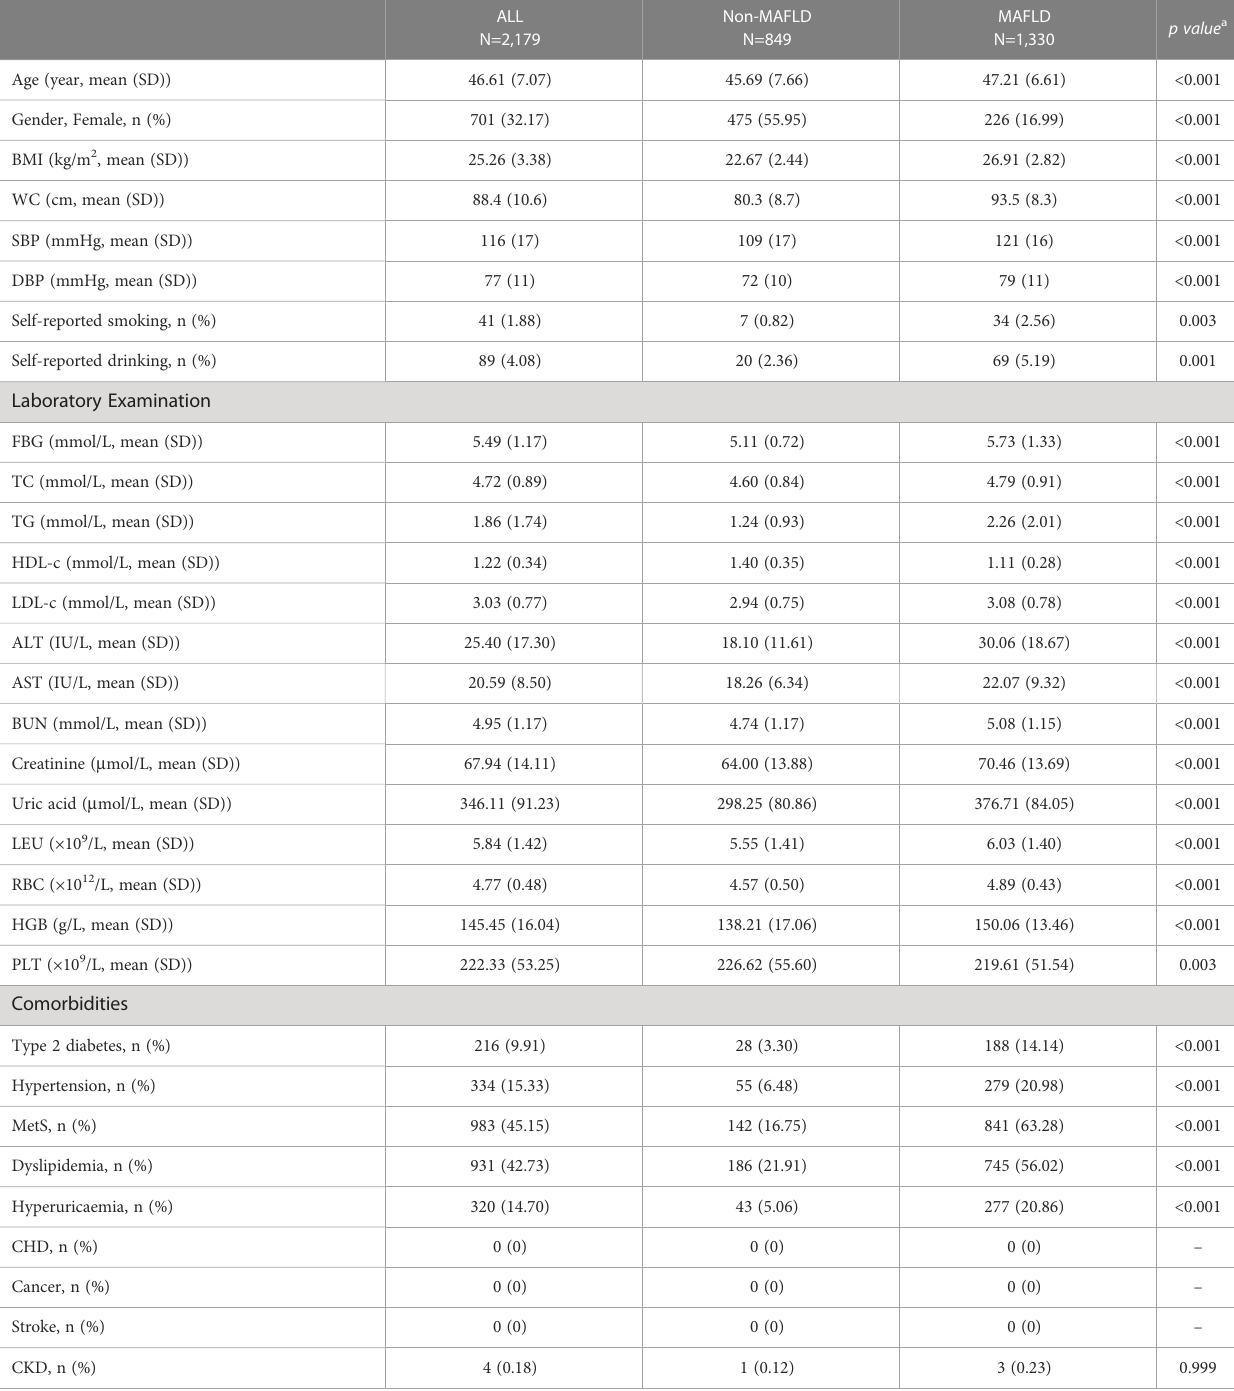
TABLE 3 Baseline characteristics for the longitudinal